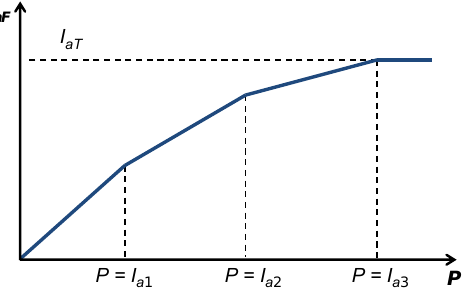
Figure 4. Variation of I aF (Eqs. 14 and 15) with P for the scenario presented in Fig. 3.